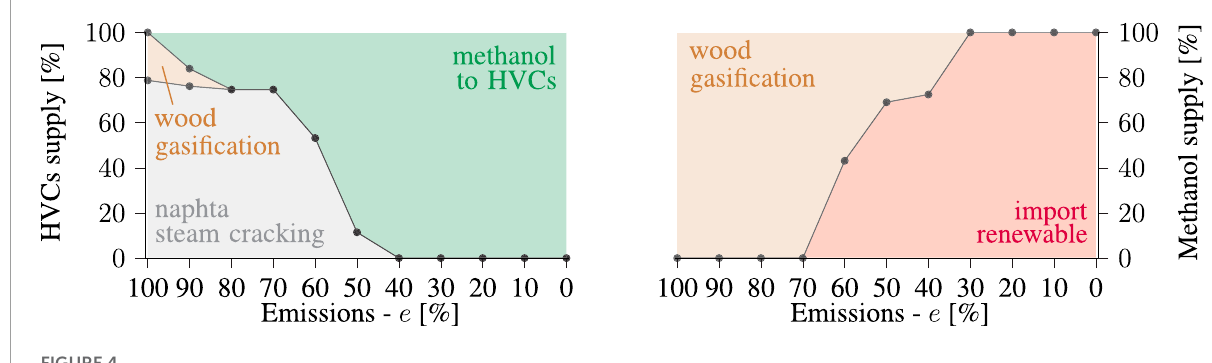
FIGURE 4 Breakdown of the typology of conversion processes used in the supply of the non-energy demand of HVCs (left) and methanol